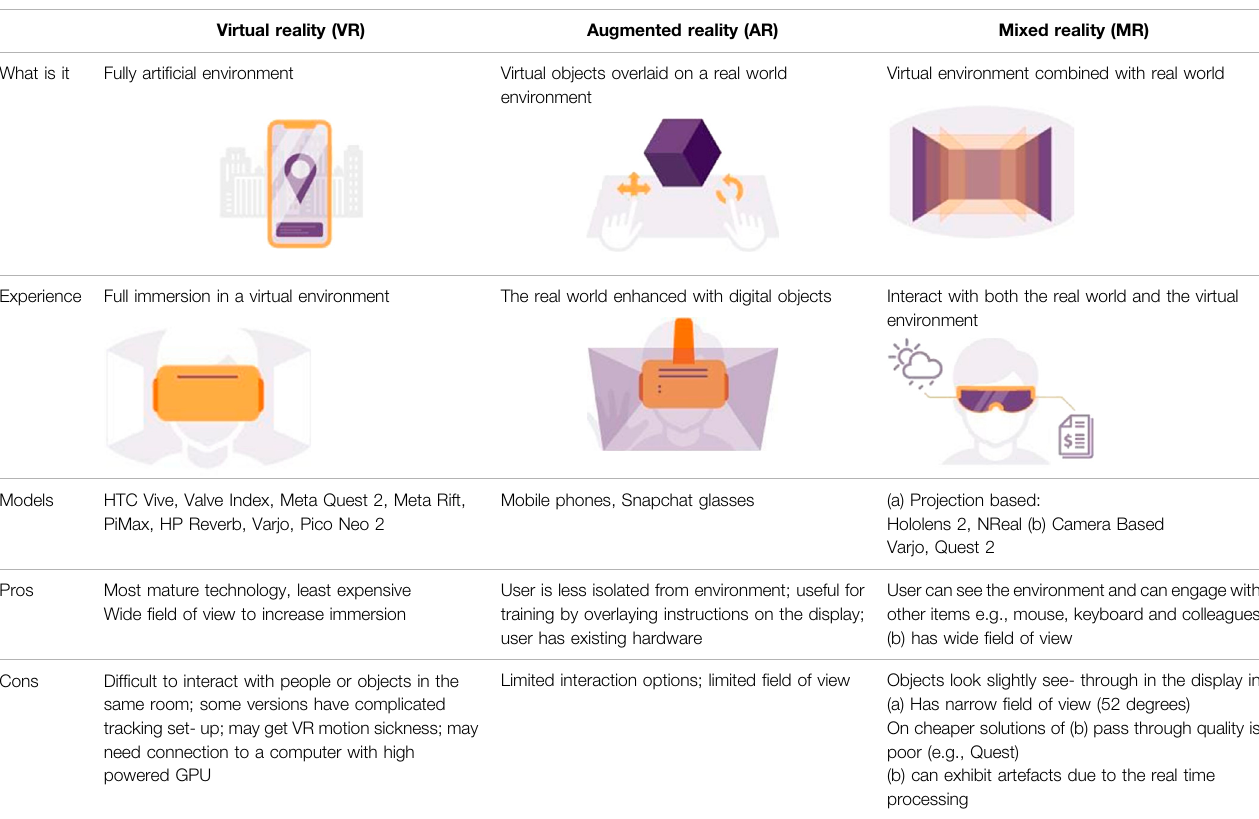
TABLE 1 | Summary of types of XR and their advantages/disadvantages (adapted from https://www.forbes.com/sites/quora/2018/02/02/the-difference-between-virtual-